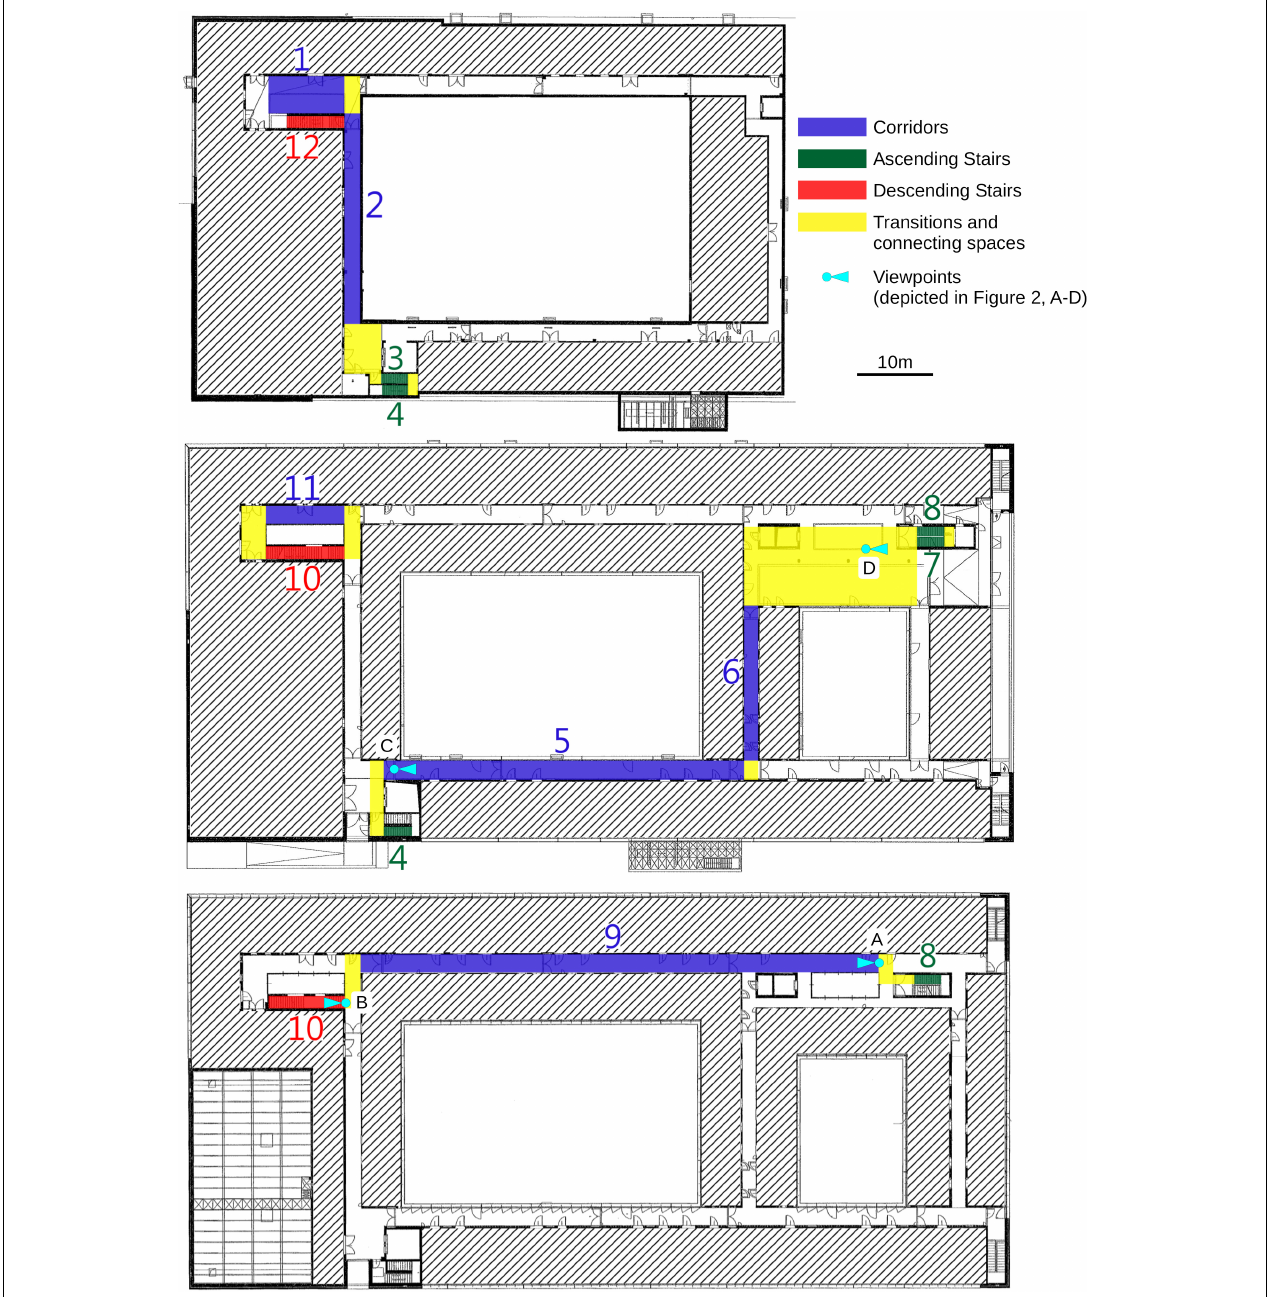
FIGURE 1 | Layout of the three floors ( top panel: basement, middle panel: street level; and bottom panel: one floor above street level); of the experimental site and the selected walkway. Different sections are classified by color coding (see legend) and numbered in order of passing. Interior walls and structures irrelevant to the experiment grayed out for data-protection reasons. Map is to scale, scale bar corresponds to 10